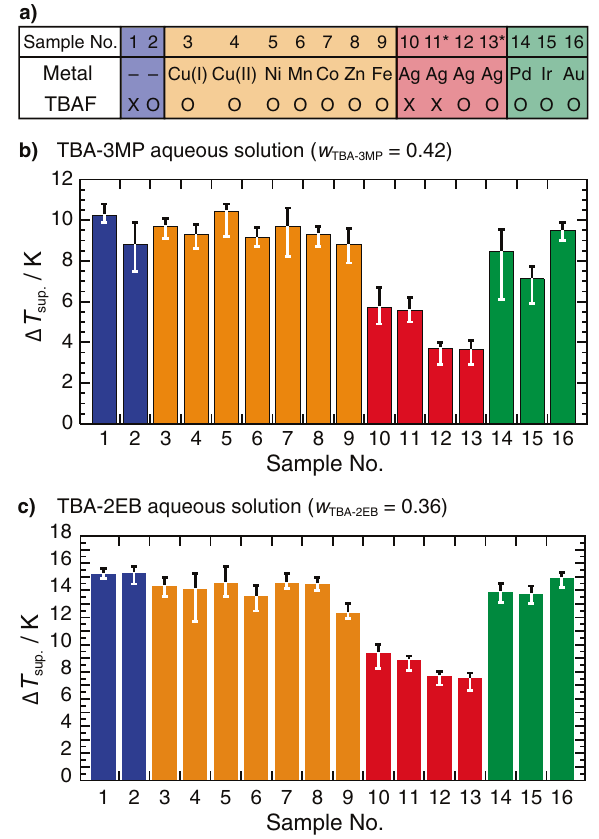
Fig. 1 Effect of metallic carboxylates on the degree of supercooling. a List of samples #1 to #16. The additive(s) was (were) added to the tetra- n - butylammonium 3-methylpentanoate (TBA-3MP) and tetra- n - butylammonium 2-ethylbutyrate (TBA-2EB) aqueous solution with the mass fractions ( w TBA-3MP = 0.42 and w TBA-2EB = 0.36) at a molar ratio of metal: F: TBA-3MP (or TBA-2EB) = 1: 10: 2000. The symbols O and X stand for “ with tetra- n -butylammonium fl uoride (TBAF) ” and “ without TBAF ” , respectively. All metal species are added as metallic acetates except for samples #1, #2, #11, and #13. In samples #11 and #13, silver pentanoate was used instead of silver acetate. Samples #3-#9 and #14-#16 are other metallic acetates with different valences. b Degree of supercooling ( Δ T sup. ) in the TBA-3MP semiclathrate hydrate formation (decomposition temperature is 278.1 K). c Degree of supercooling ( Δ T sup. ) in the TBA-2EB semiclathrate hydrate formation (decomposition temperature is 283.2 K 43 ). The coexistence of silver carboxylate with TBAF yields a small degree of supercooling. All error bars represent standard